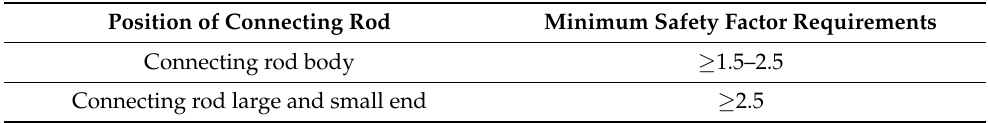
Table 5. Safety factors of Kirasu Shveli method.